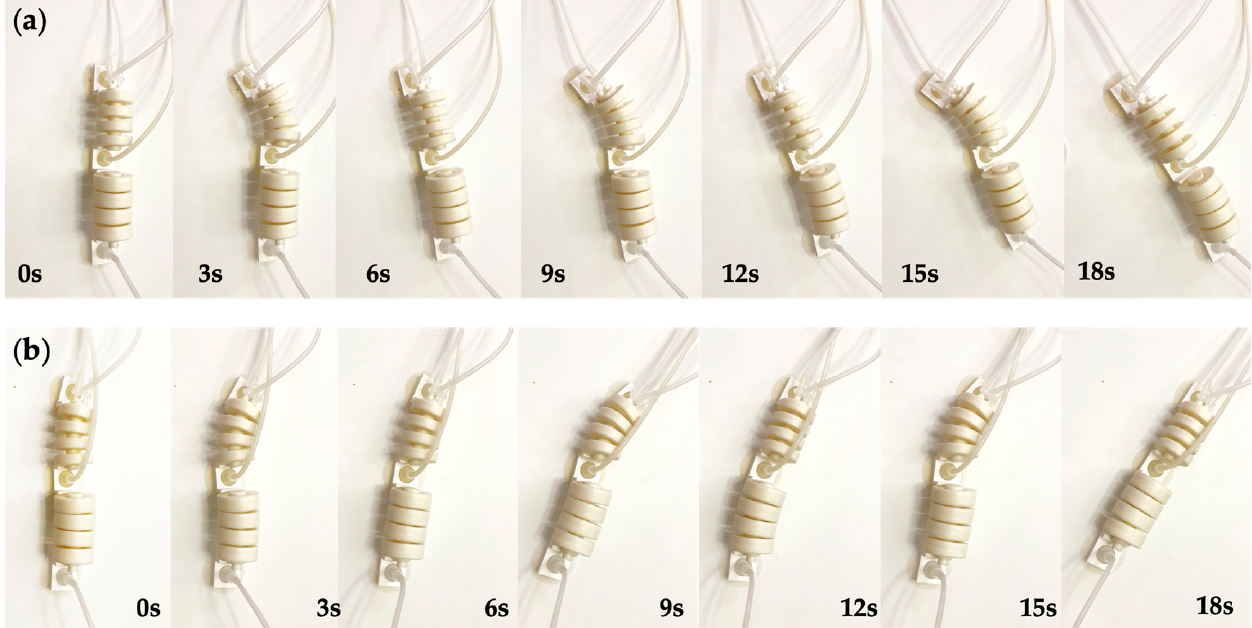
Figure 22. The turning locomotion testing. ( a ) Right turning. ( b ) Left turning.